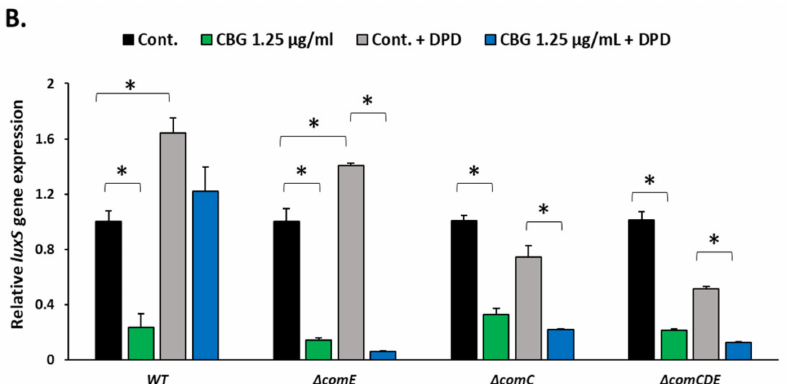
Figure 8. Effect of CBG on luxS gene expression. ( A ). Expression of luxS gene in various S. mutans strains incubated in the absence or presence of 1.25 µ g/mL CBG and/or 1 µ g/mL 21-CSP for 4 h in comparison to control as determined by real-time PCR using respective primers. ( B ) . Expression of luxS gene in various S. mutans strains incubated in the absence or presence of 1.25 µ g/mL CBG and/or 5 µ M DPD (pre-AI-2) for 4 h in comparison to control as determined by real-time PCR using respective primers. n = 3; * p <